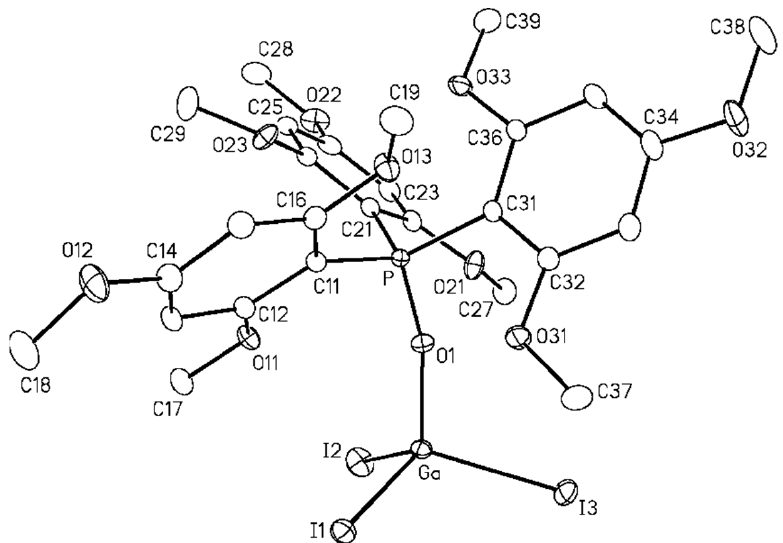
Figure 3. Perspective view of the [{tris(2,4,6-trimethoxyphenyl)phosphine oxide}GaI 3 ] (3) molecule, showing the atom labeling scheme.